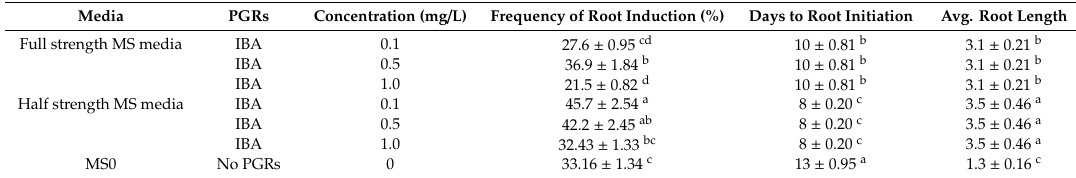
Table 3. Development of roots from the regenerated shoots in MS full or half strength medium with various concentrations of indole butyric acid (IBA) in L. usitatissimum . Values represent mean data of each treatment with ± standard error. Data was collected after four weeks culture period. Data with di ff erent letter(s) is statistically significant at p ≤ 0.5. MS0: MS media with no plant growth regulators.